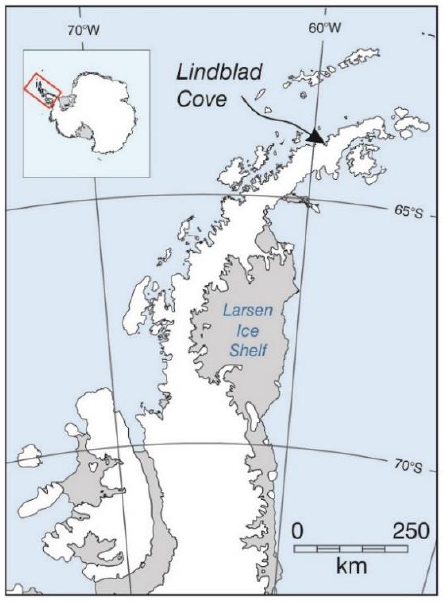
Figure 1. Study area location. Geographic Coordinate